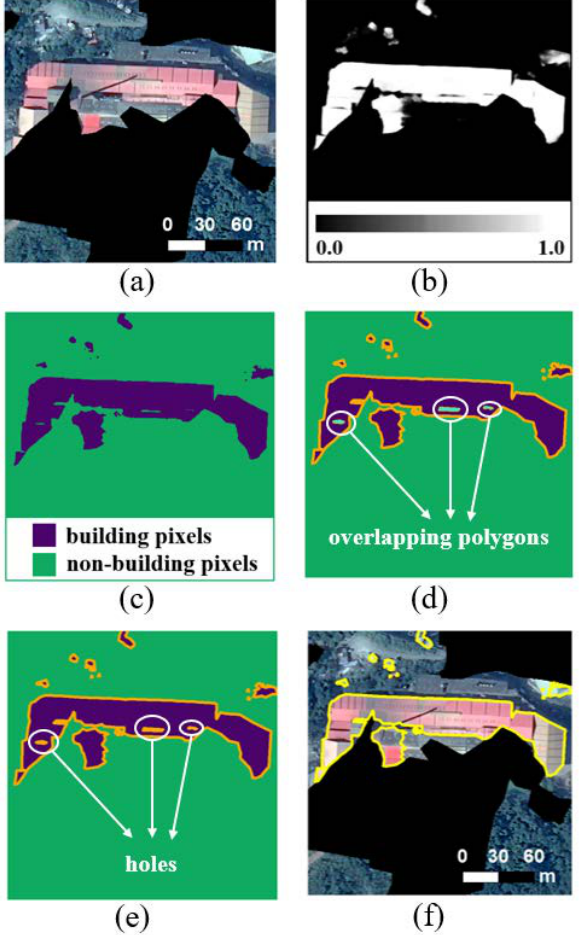
Figure 6. An example of adjacent buildings in